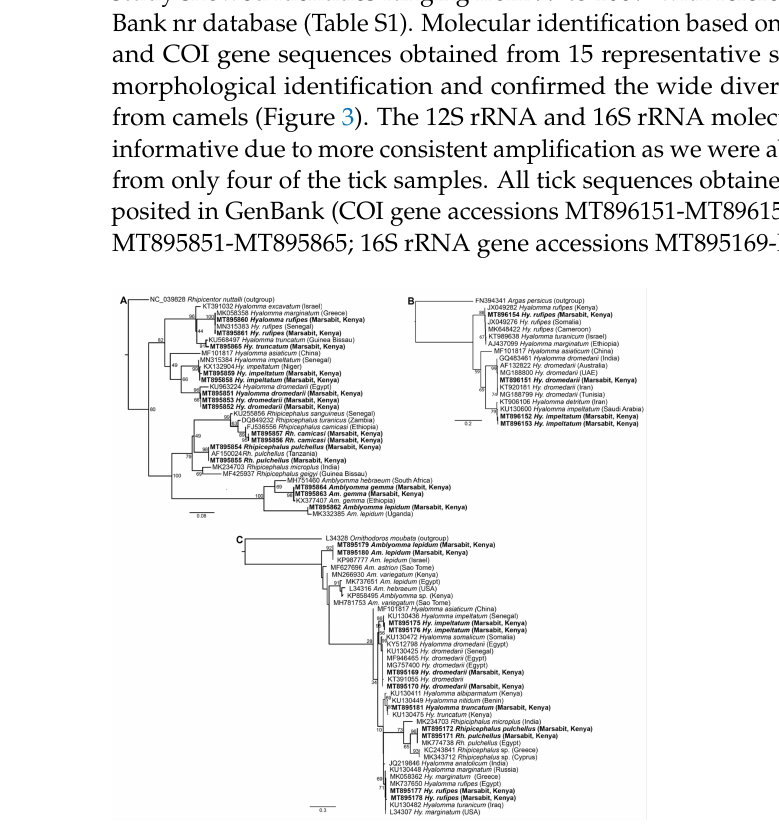
Figure 3. Maximum likelihood phylogenetic trees of representative gene sequences from samples of ticks collected from camels in Northern Kenya. ( A ) 12S rRNA, ( B ) COI mitochondrial and ( C ) 16S rRNA gene sequences. Sequences obtained from this study, with their GenBank accession numbers, are noted in bold. Bootstrap values at the major nodes are of percentage agreement among 1000 bootstrap replicates. The branch length scale represents substitutions per site. Trees are rooted to outgroup sequences (indicated in brackets; top sequence of each